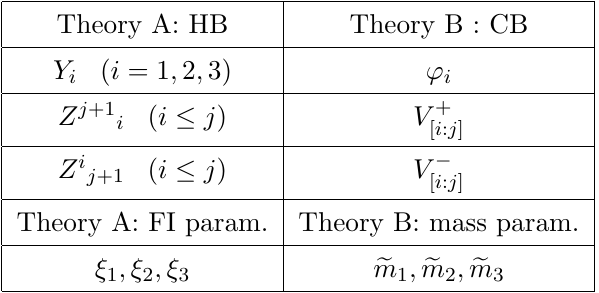
Table 5 . Mirror map of HB operators of T A and CB operators of T B , and mirror map of FI and mass